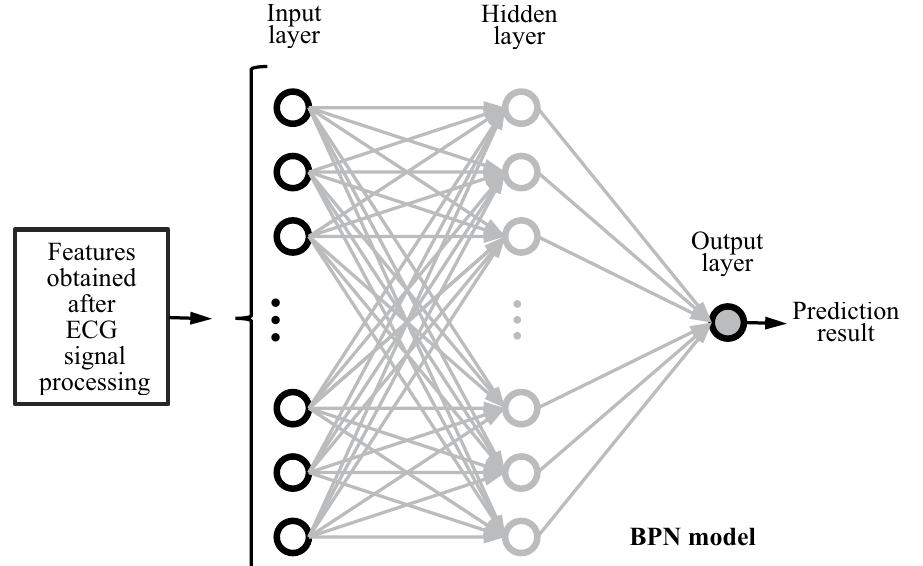
Figure 2. The structure of back propagation neural network